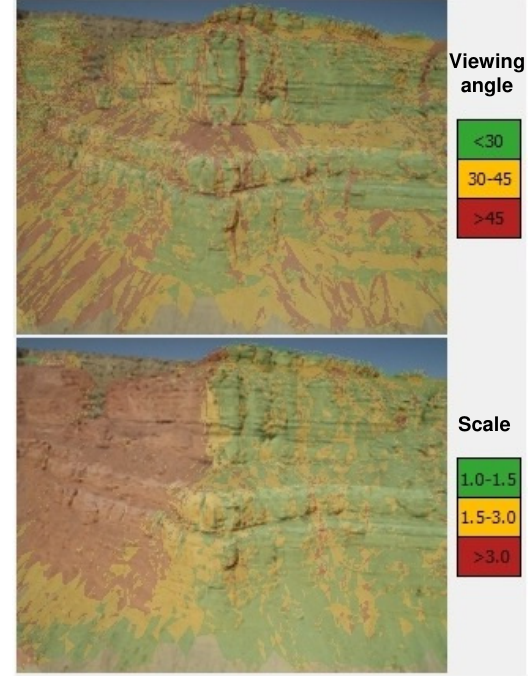
Figure 2. Image overlaid with maps of quality measures classified into three categories: high/good (green), medium (orange) and low/bad